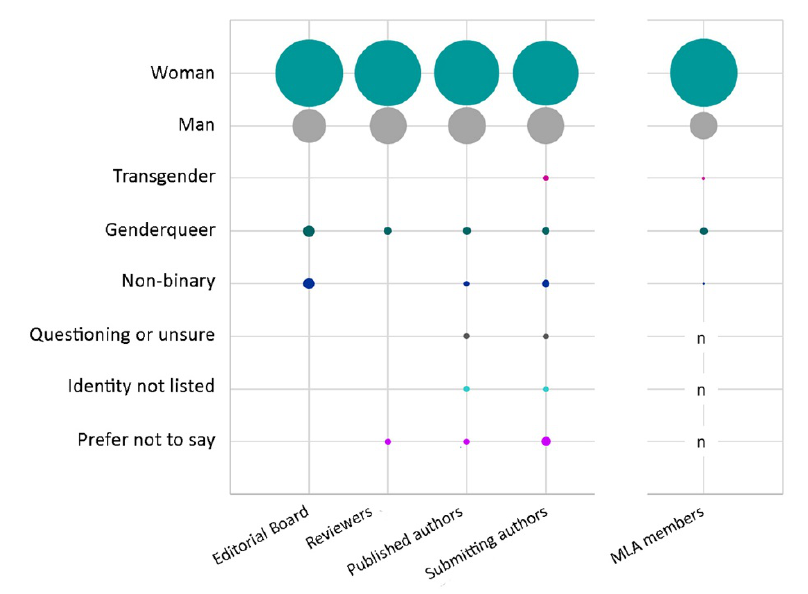
Figure 2 Gender identity of JMLA editorial board members, reviewers, and published and submitting authors (compared with MLA members